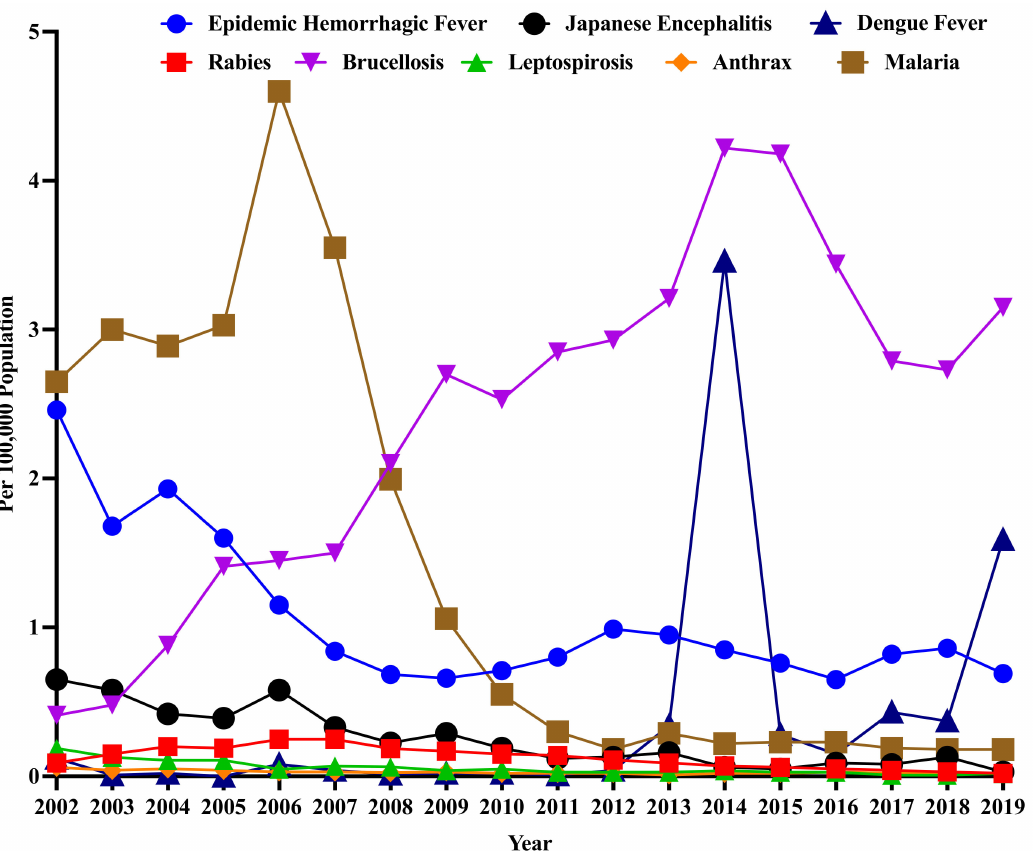
Figure 1. Incidence of zoonoses in China (excluding diseases for which no continuous data are available). Source: China Health Statistical Yearbook